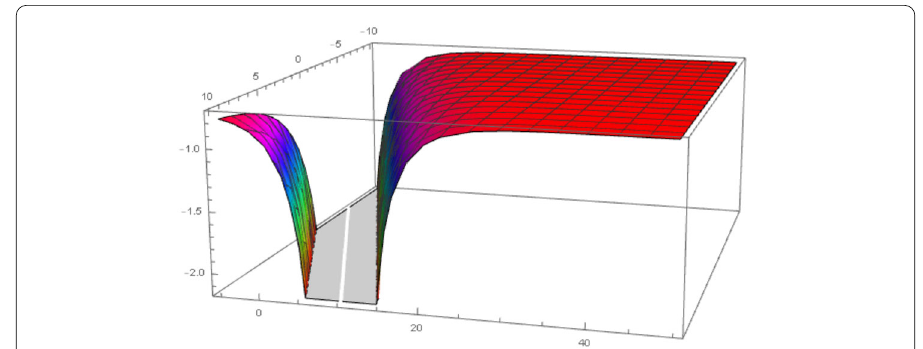
Figure 7 Kink wave of u 9 ( η ) for α = 0.30, a 1 = 11, λ = 0.77, b 0 = 1, V = 10, b 1 = 100